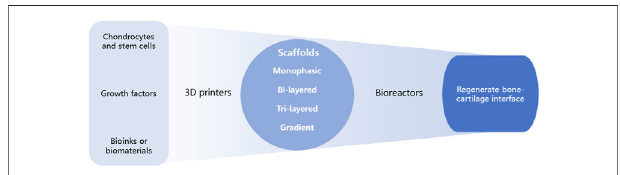
FIGURE 1 | Schematic process of 3D printing for regenerating bone- cartilage interface.